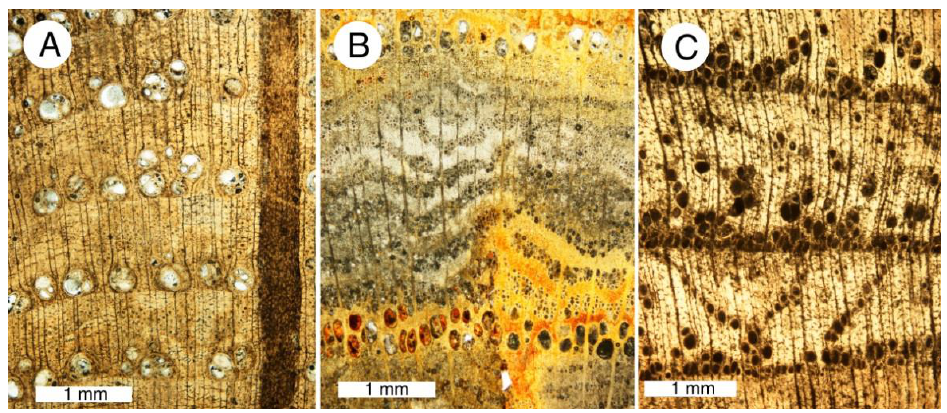
Figure 6. Thin sections of phosphatized angiosperm wood from Bruneau, Idaho USA, transverse orientation. ( A ) Carya sp.; ( B ) Ulmus sp.; ( C ) unidentified hardwood. Photos courtesy of T.A. Dillhoff, used with permission.